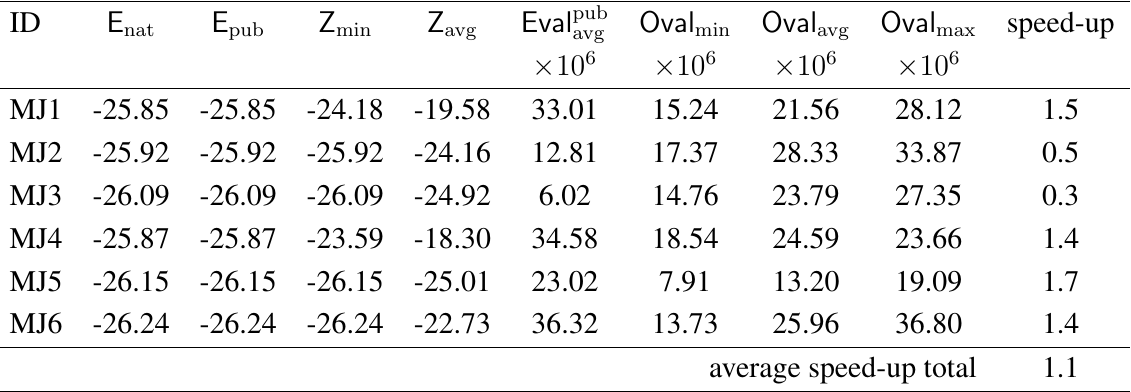
Table 6. Results for the M-J Model on 3D cubic lattices for benchmarks from Table 2. E are the results published in [41]. Eval pub for PLSfrom [41].